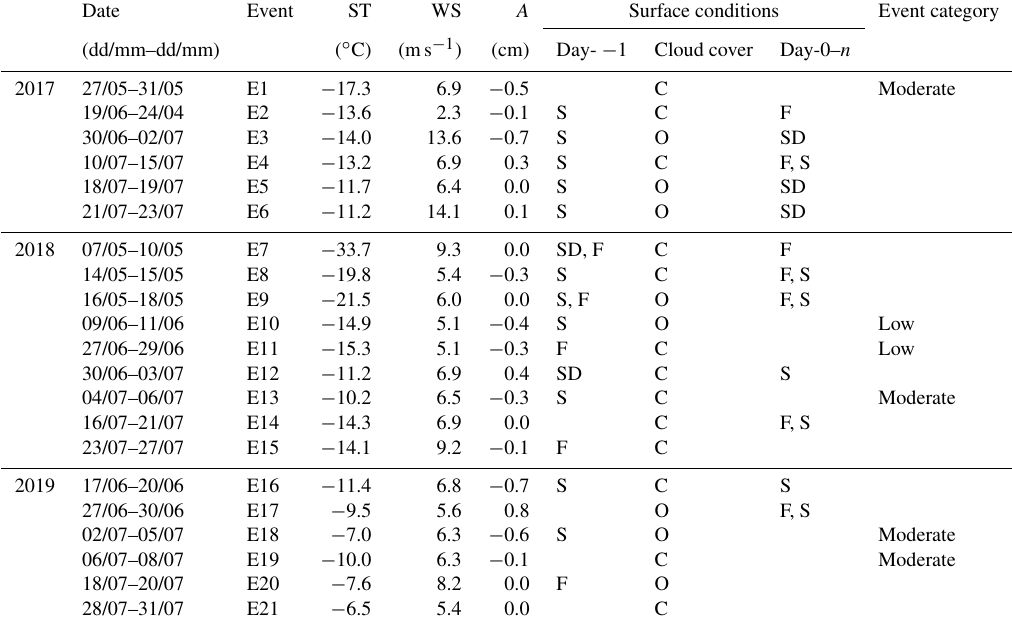
Table A1. Description of conditions for SSA decays captured by decreased threshold. Duration and conditions for all 21 events defined by the threshold. Observations were made of snowfall, snowdrift and ground fog. Presented here are the dates, event number, mean surface temperature (ST), maximum wind speed (WS), accumulation ( A ), and surface conditions including those recorded during the day (24h) preceding each event (Day-1), cloud cover, observations of surface perturbations during the events based on field observations (Day-0– n ), and finally the wind speed category for SSA decay event analysis (Event category). In the “Surface conditions” columns, S, SD and F stand for snowfall, snowdrift and ground fog respectively. C in “Cloud cover” indicates clear sky and O indicates